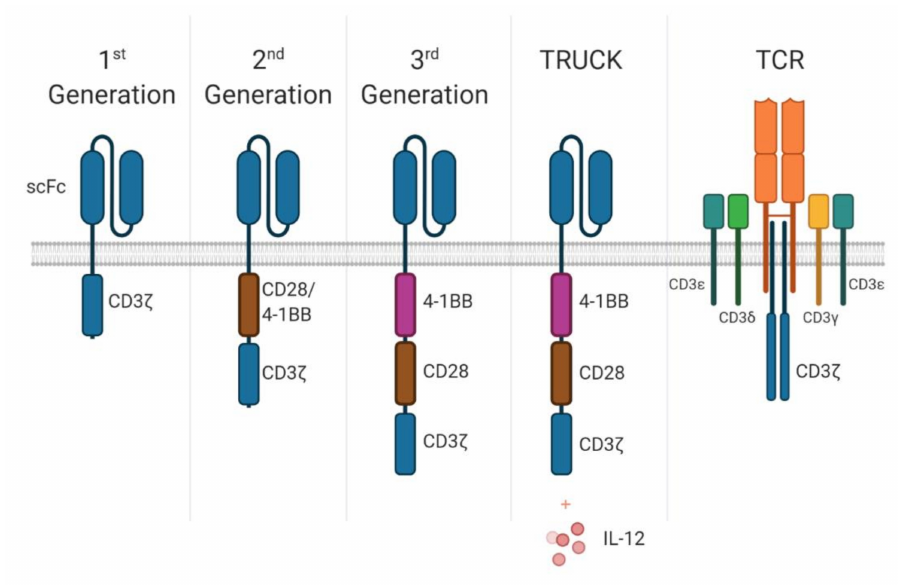
Figure 2. Generational development of chimeric antigen receptors. Chimeric antigen receptors were first developed as extracellular single-chain variable fragments (fused light and heavy chain from immunoglobulins) fused to the intracellular CD3 ζ signalling domain. Then, 2nd generation CARs included the CD28 or 4-1BB co-stimulatory domains, while 3rd generation CARs included both co-stimulatory domains. The “T-cells Redirected for Universal Cytokine Killing” (TRUCKs) 4th generation also includes a cytokine payload such as IL-12. Conventional T-cell receptors on the other hand have signalling domains split across multiple